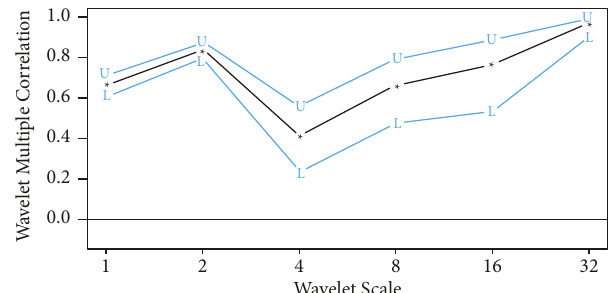
Figure 10: Wavelet multiple cross correlation between systematic risk of Asia (18/08/2010–03/11/2020).